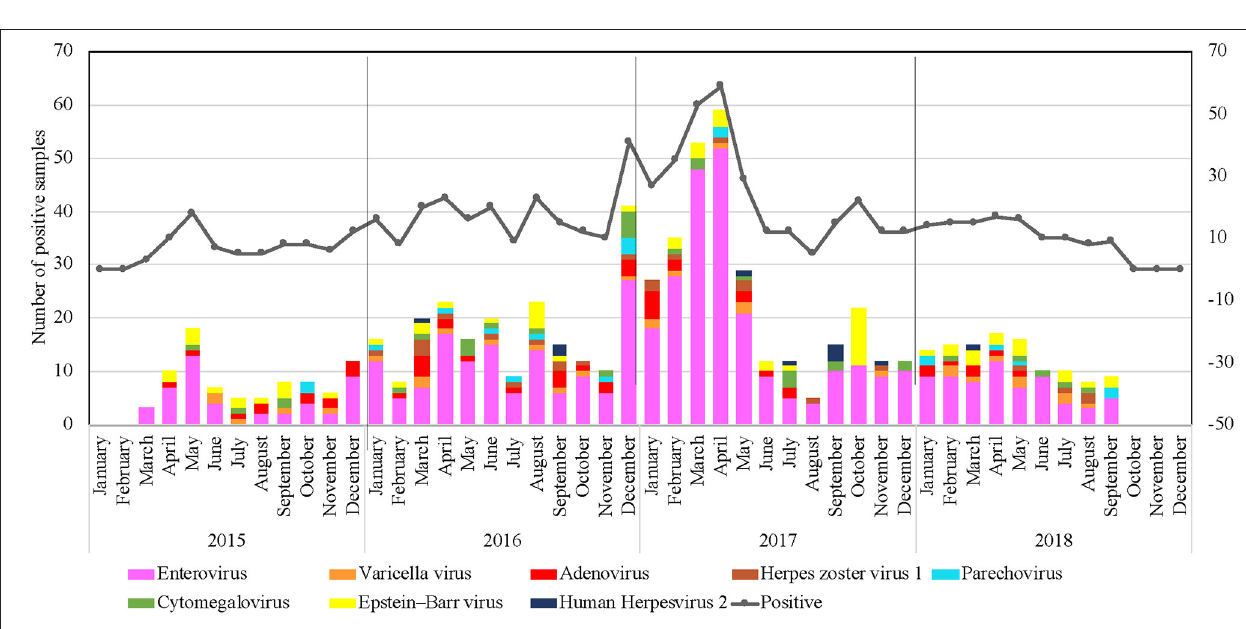
FIGURE 2 | Clustered column chart denoting number of VM positive cases detected in Qatar during the study period (January 2015 to December 2018). X-axis: month; y-axis: Number of positive